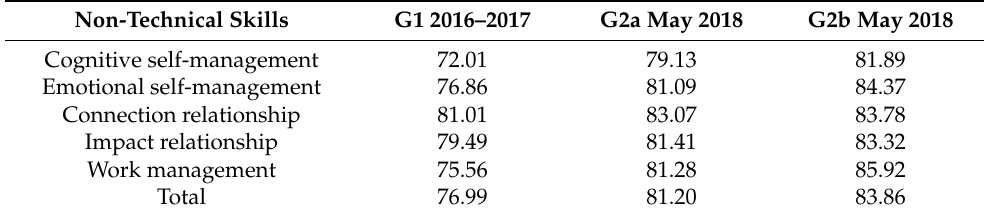
Table 5. Comparison of non-technical skills acquired by students in this